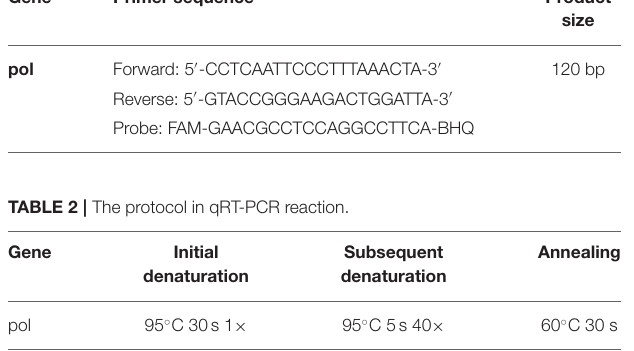
TABLE 1 | Sequences of the primers used for detection of cytokine. Gene